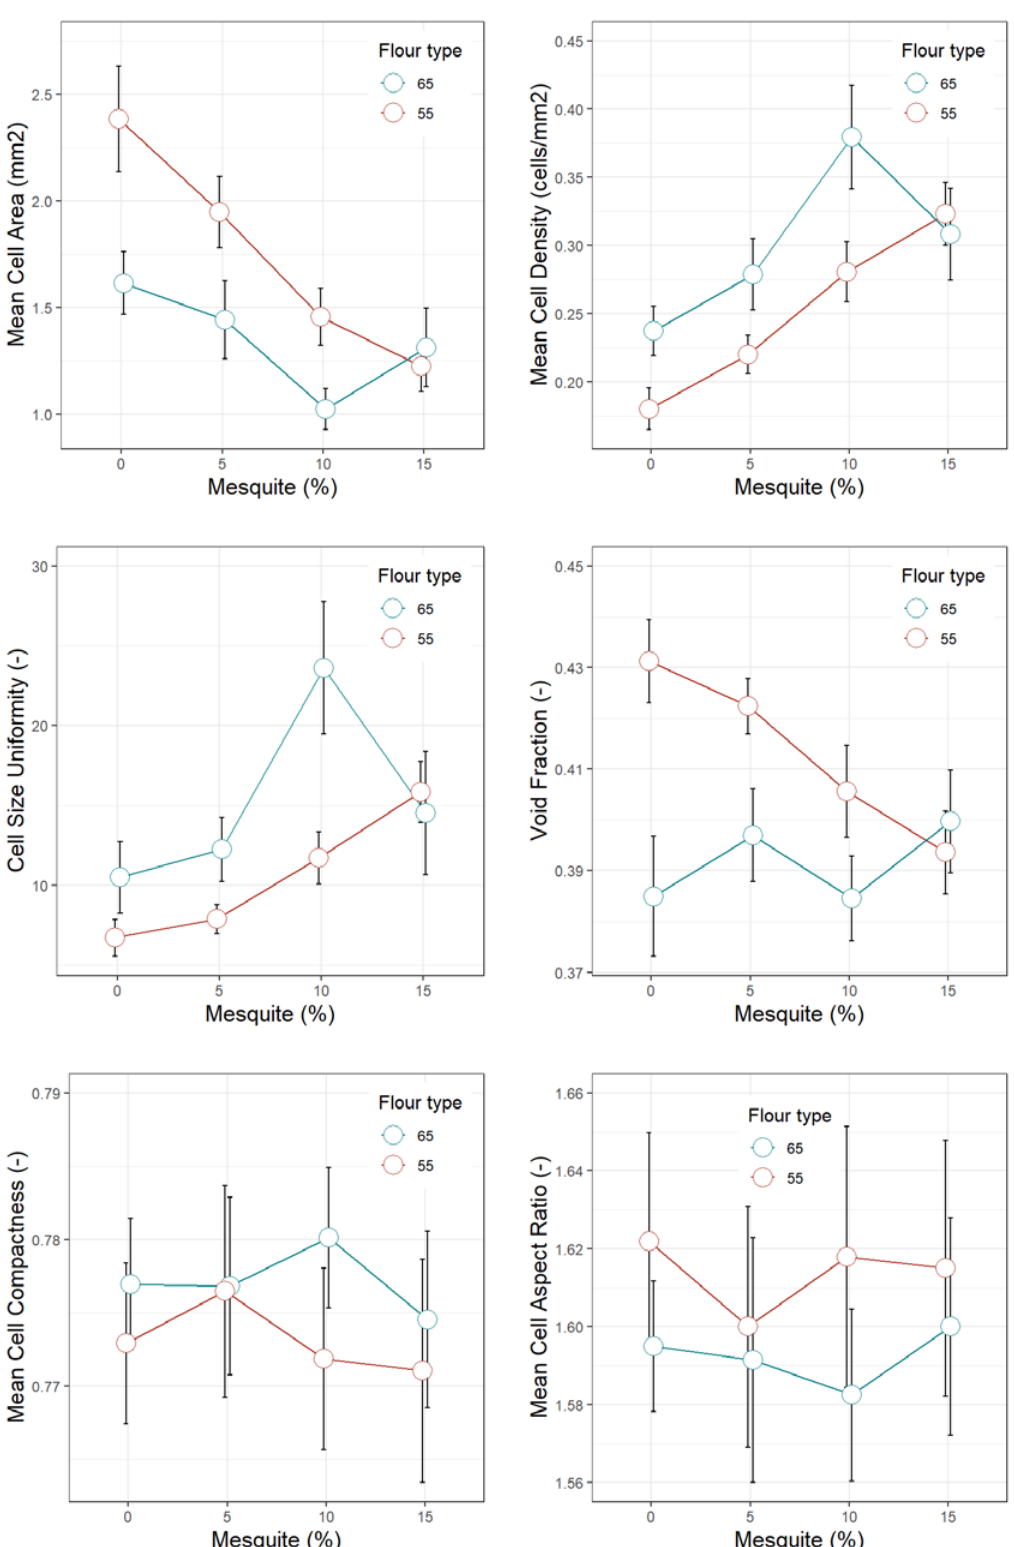
Figure 5. Image analysis crumb features of bread made of wheat flour type 65 or 55 partially replaced with mesquite pod flour.